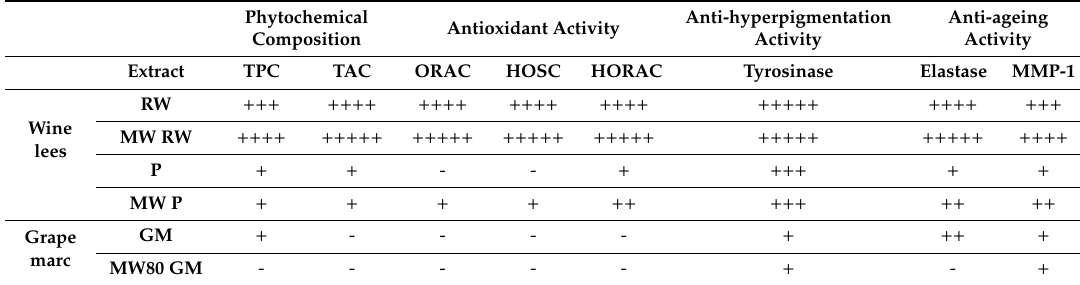
RW—red wine lees conventional extract; MW RW—MW-pretreated red wine lees extract; P—Port wine lees conventional extract; MW P—MW-pretreated Port wine lees extract; GM—grape marc conventional extract; MW80 GM—MW-pretreated grape marc extract (max. temp. 80 ◦ C).